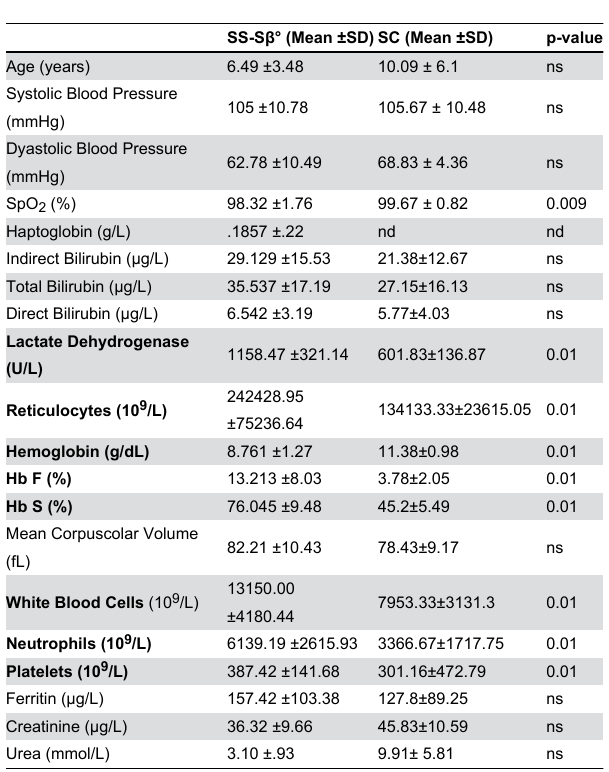
Table 2. Markers of endothelial activation, thrombin generation and fibrinolysis for SS/Sβ° patients, SC patients and